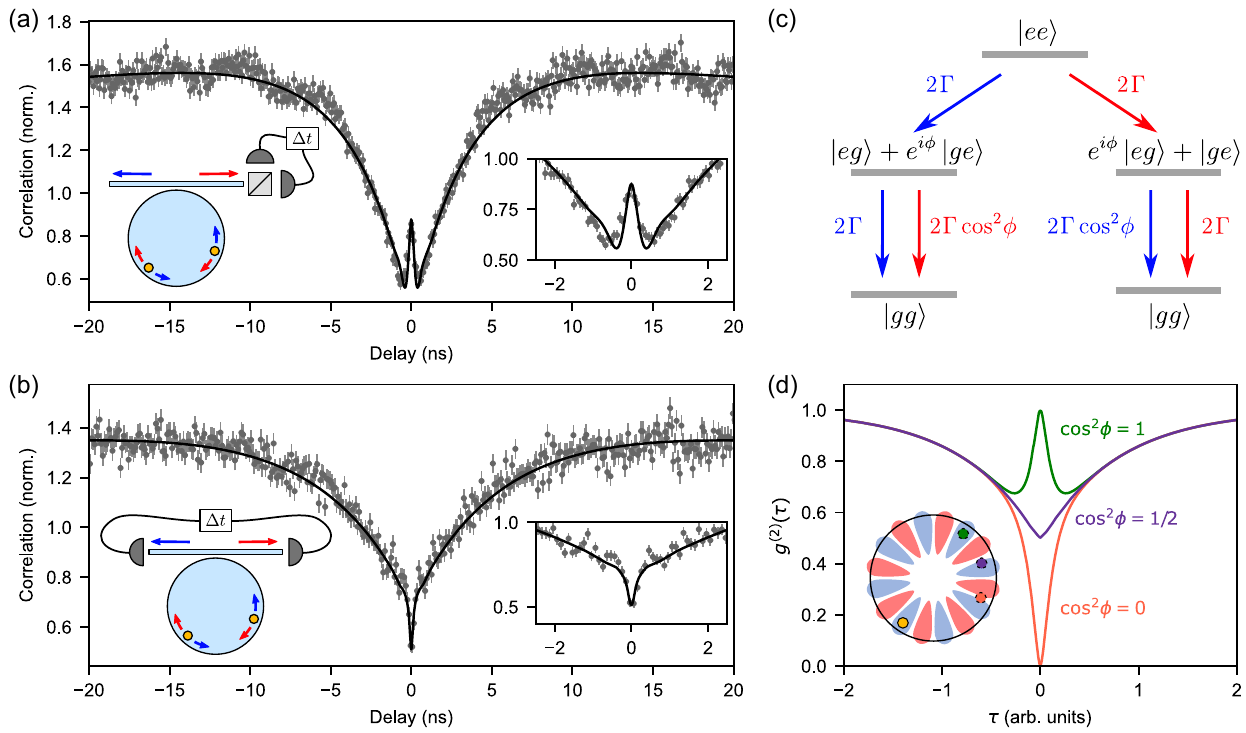
FIG. 3. Superradiant emission of two V color centers. (a) Second-order correlation of the photon emission along one waveguide Si direction displays bunching at zero time delay, a signature of superradiance. Inset: enlargement of the superradiance feature. Error bars represent standard error. (b) The relative phase ϕ of the emitters impacts the cross-correlation photon statistics between the opposite waveguide directions and can produce antibunched emission. The solid line in (a) and (b) is the numerical fit based on a five-level model [37] of the V [normalized to g ð 2 Þ ð τ → ∞ Þ ¼ 1 ]. (c) The level structure representing the pair of two-level-system emitters decaying into Si degenerate clockwise (red arrows) and counterclockwise (blue arrows) optical modes. The corresponding transition rates are indicated next to the arrows, where Γ is the unmodified single-emitter decay rate into a propagating mode. (d) Theoretically predicted phase- dependent cross-correlation between clockwise and counterclockwise modes for a pair of ideal two-level emitters. The inset shows a schematic of the mode profile and the two emitters. The placement of the second emitter (relative to the first emitter, yellow) corresponds to the three